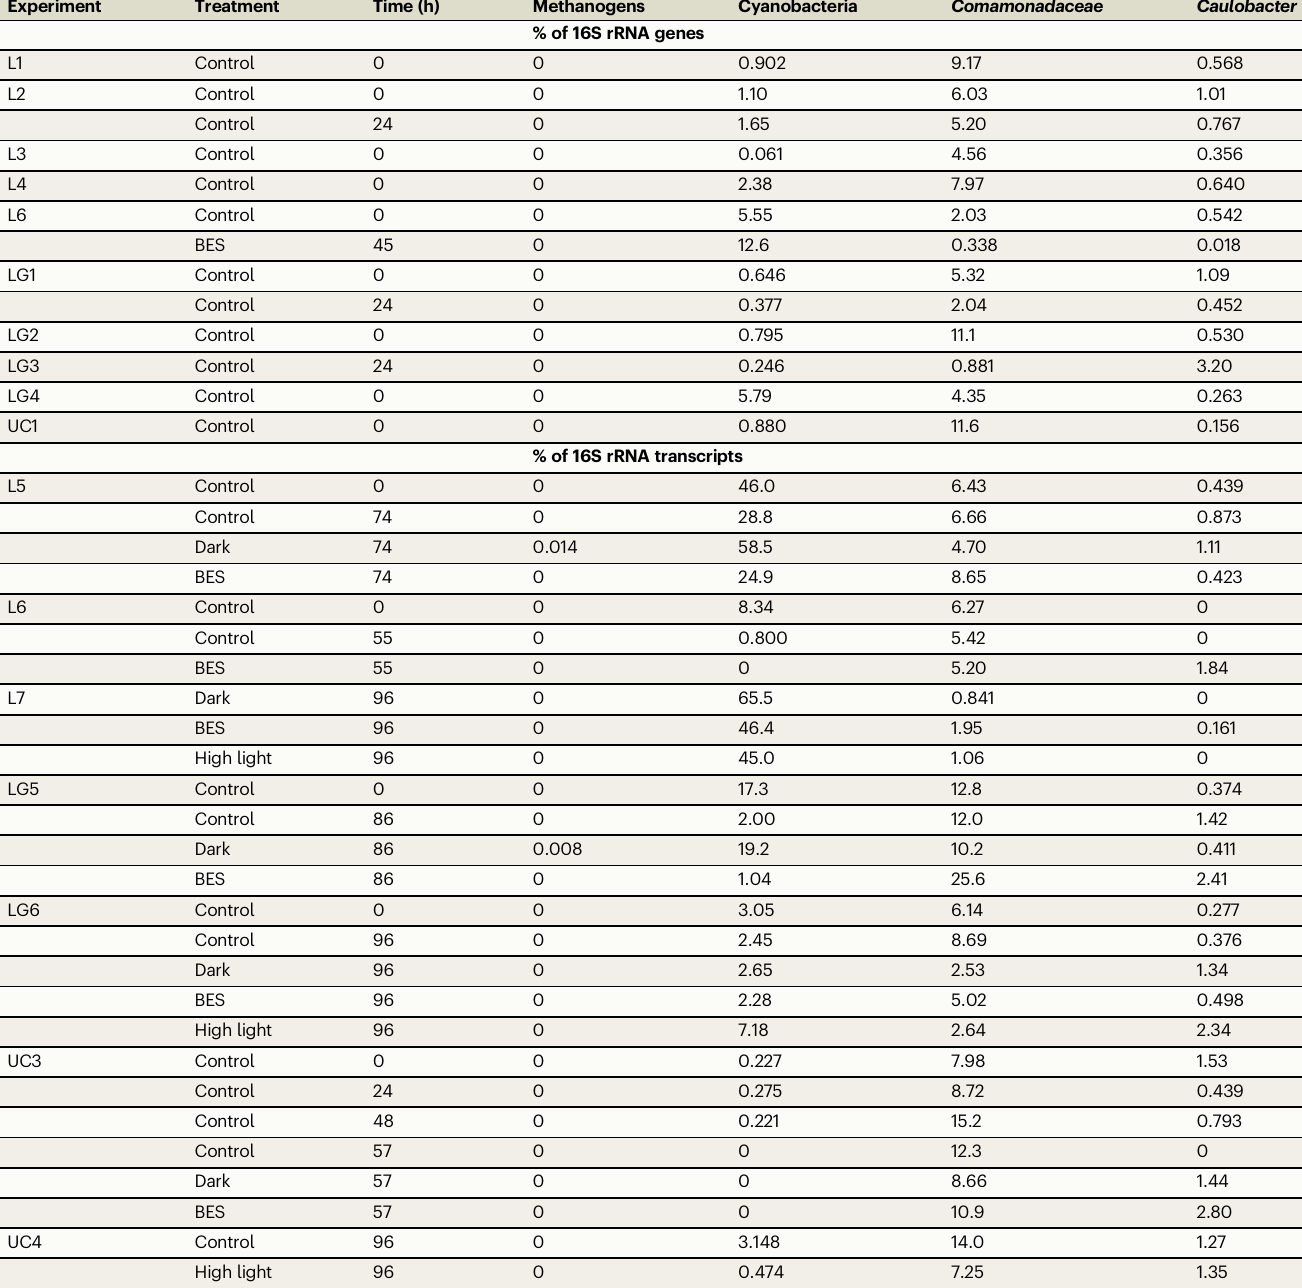
Table 1 | Relative abundance of methanogens, Cyanobacteria, Comamonadaceae , and Caulobacter as a percentage of 16S rRNA genes and transcripts sequenced in different experiments and treatments (where BES indicates addition of the methanogenesis inhibitor 2-bromoethanesulphonate)